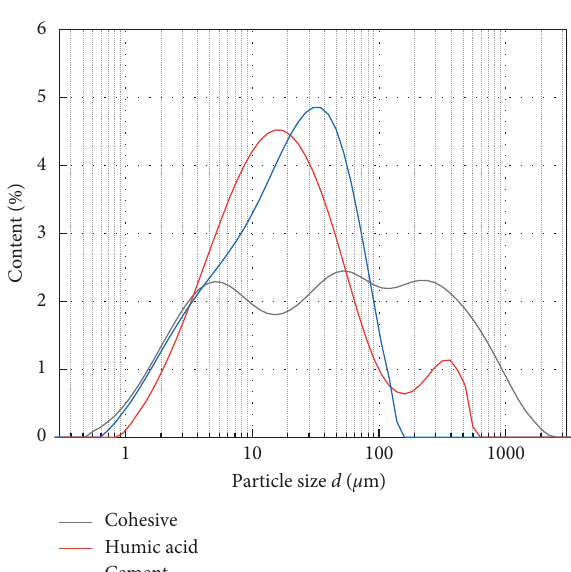
Figure 3: Particle distribution curve of the test material.